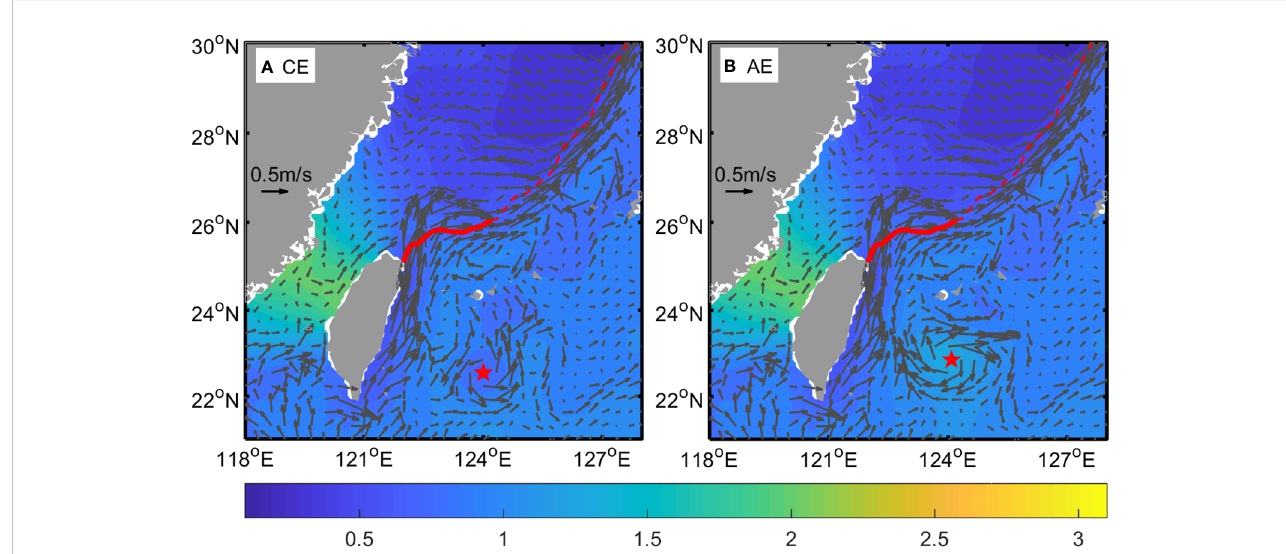
FIGURE 3 The initial sea surface heights (m) and surface current fi elds in the (A) CE and (B) AE experiments. The dashed red lines represent the 200 m isobaths along the ECS continental shelf, which are thickened with solid lines northeast of Taiwan. The red stars indicate the initial location of the eddy